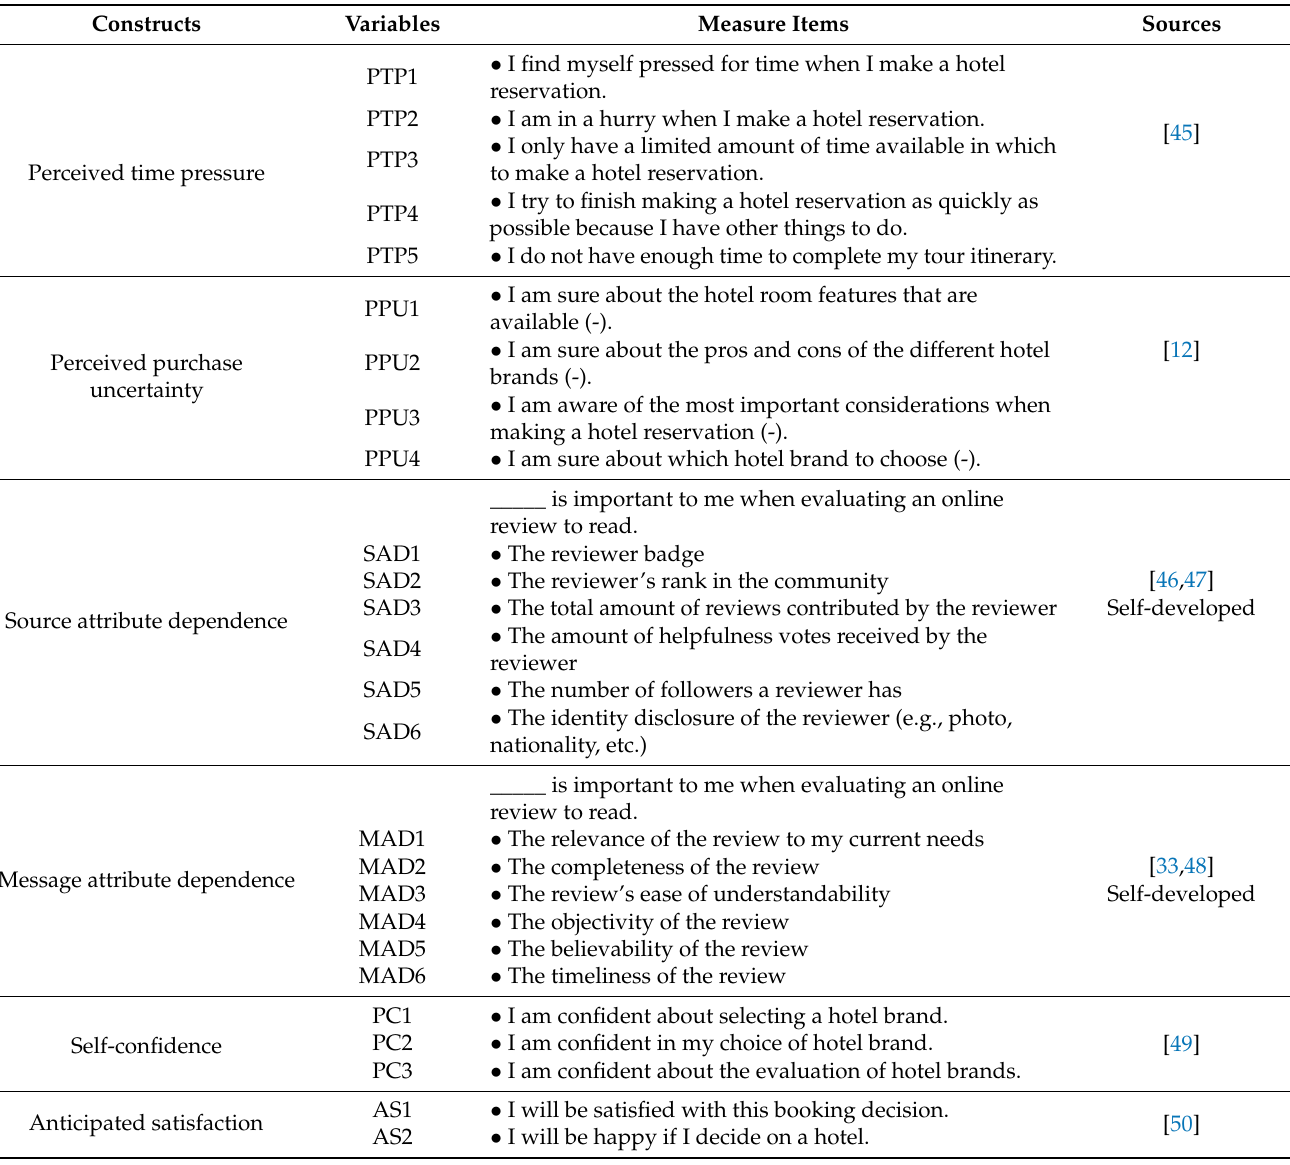
Table 1. Measures and